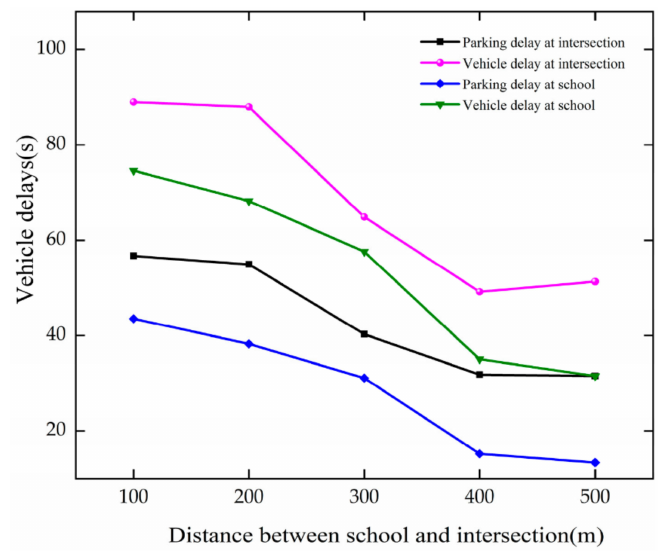
Figure 19. Variation trend of vehicle delay with DSI.